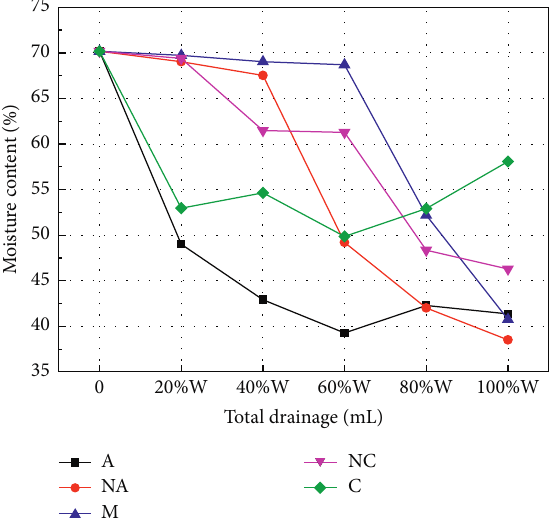
Figure 6: Moisture content at different